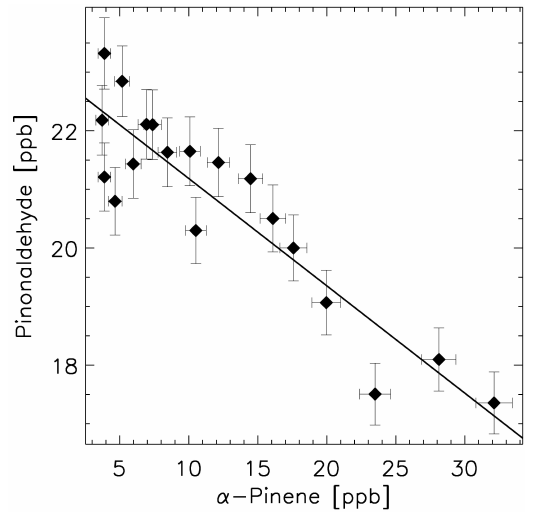
Fig. 6. Determination of the molar yield of pinonaldehyde from PTR-MS gas-phase measurement within a section of an experiment. The negative of the slope gives the approximate gas-phase molar yield. The respective fit parameters are given in Table 1b.